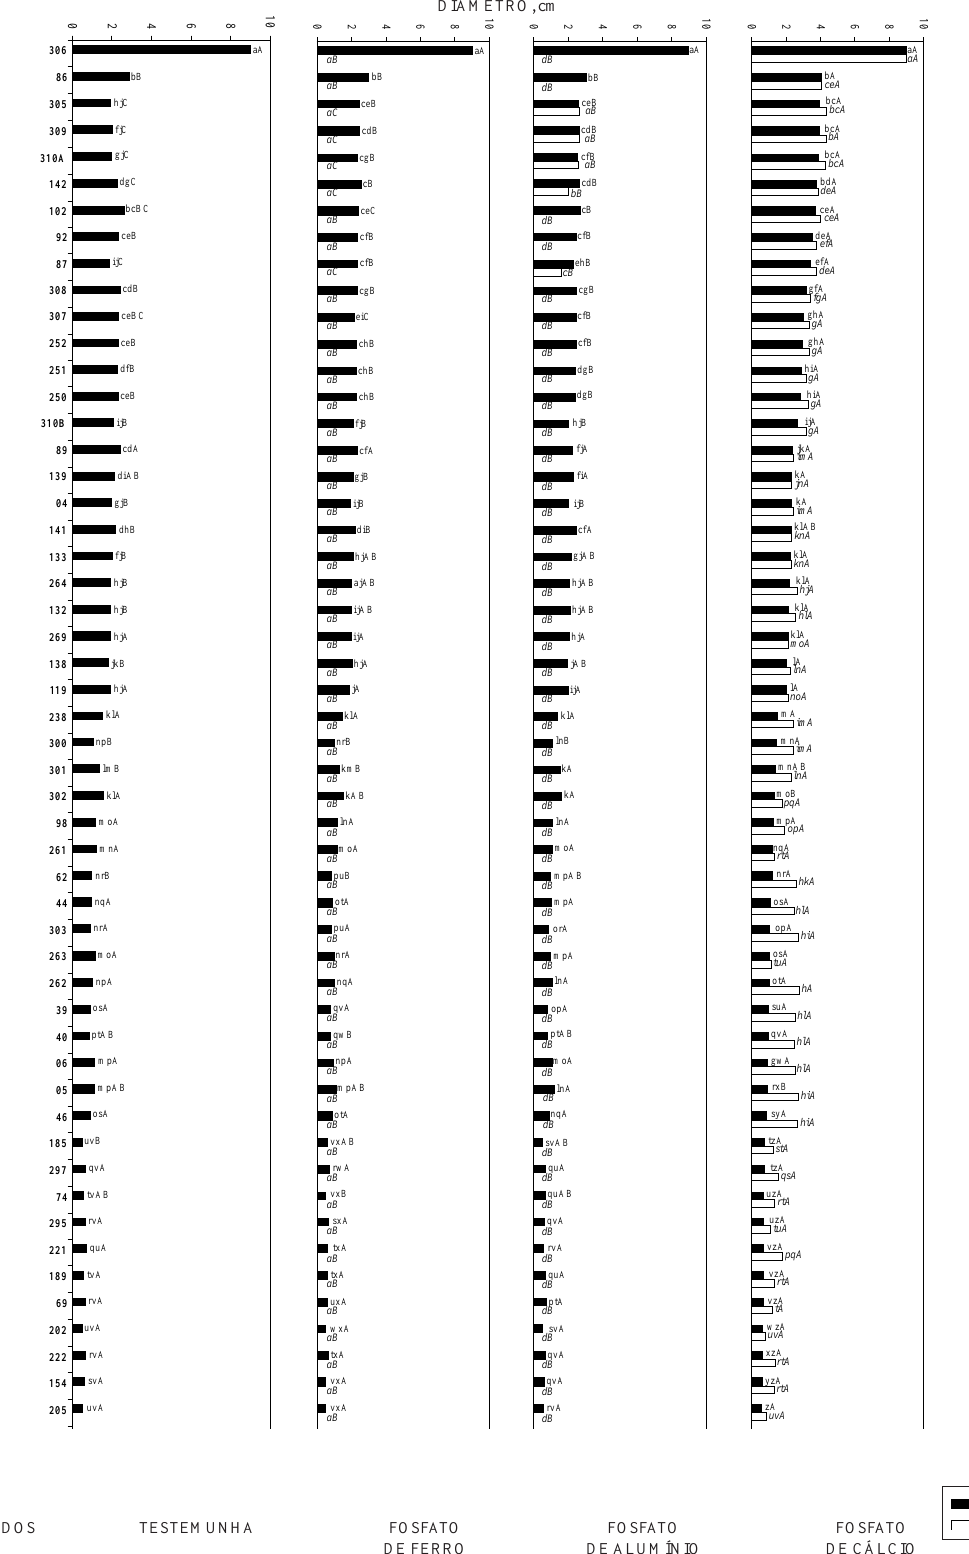
Figura 1. Diâmetro da área solubilizada e da colônia de microrganismos solubilizadores de fosfatos em meio glicose extrato levedura com diferentes fontes de fosfato. Letras em estilo normal e itálico comparam diâmetro de colônia e da área solubilizada, minúsculas e maiúsculas comparam isolados dentro de fosfato e fosfatos dentro de isolados, respectivamente, pelo teste de Tukey a